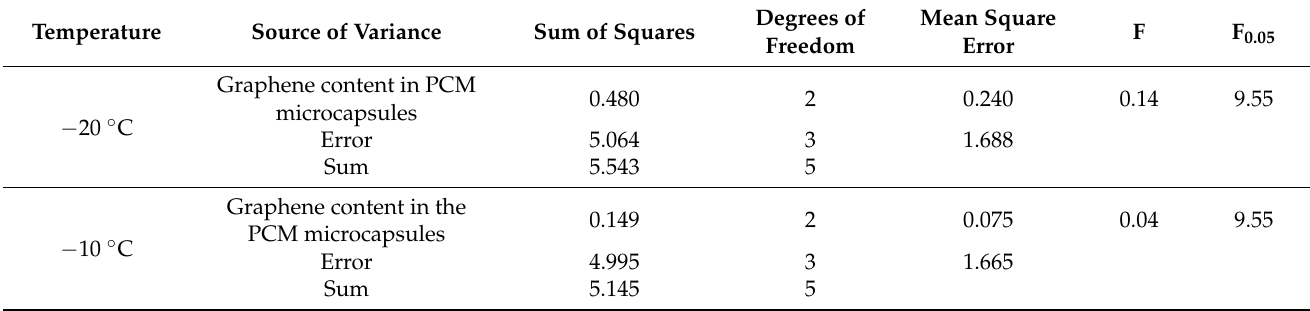
Table 6. Variance analysis of the fracture toughness results in the present SCB test.